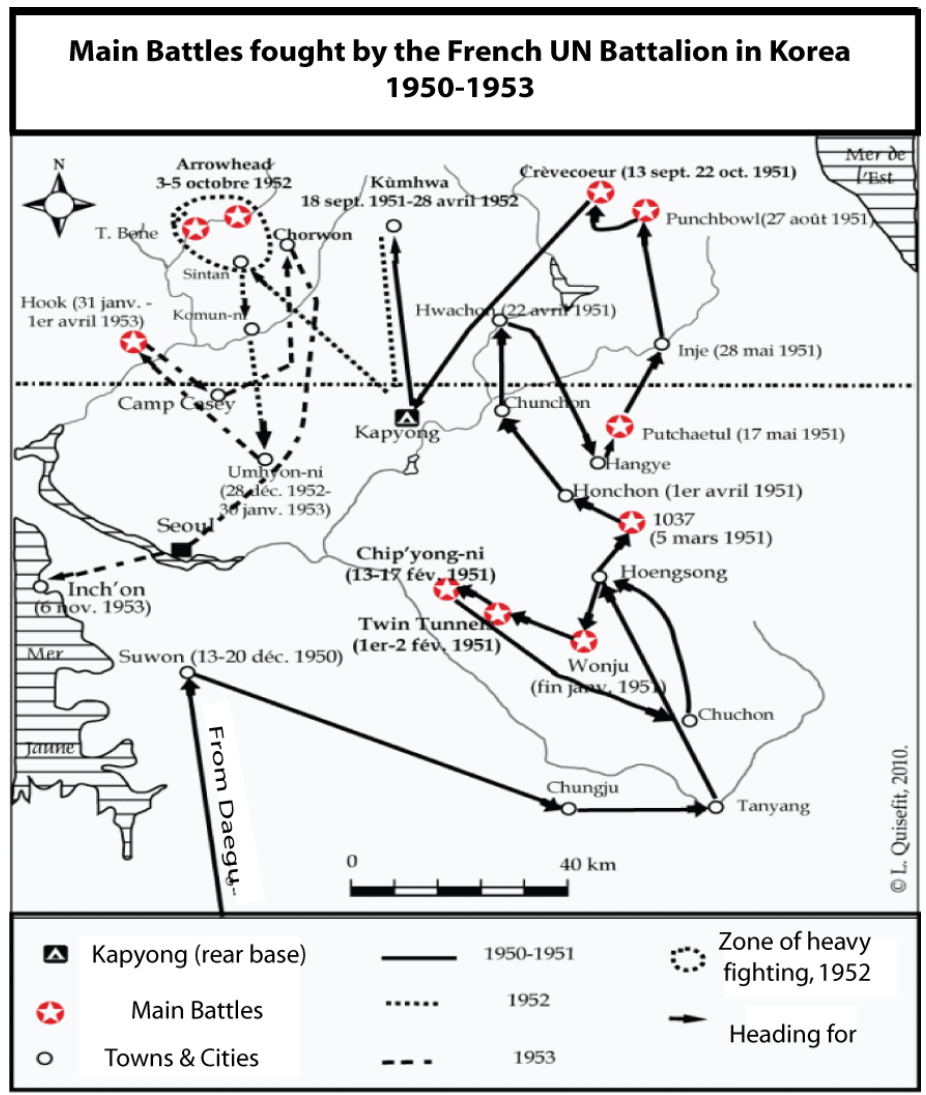
Figure 3. Map of the main battles of the French